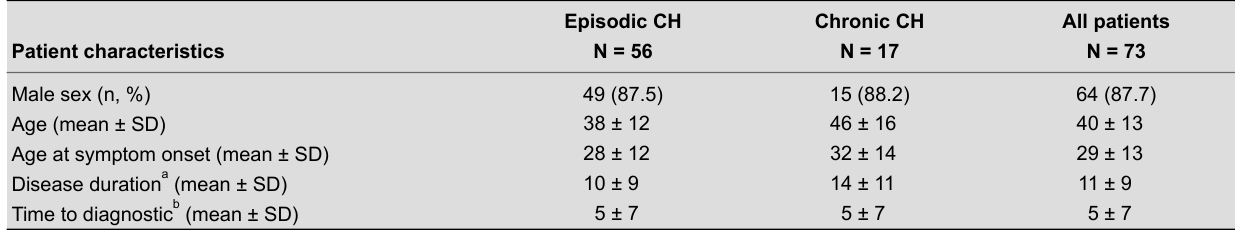
Demographic Attributes and Main Disease Features of Study Patients According to the Type (Episodic or Chronic) of Cluster Headache